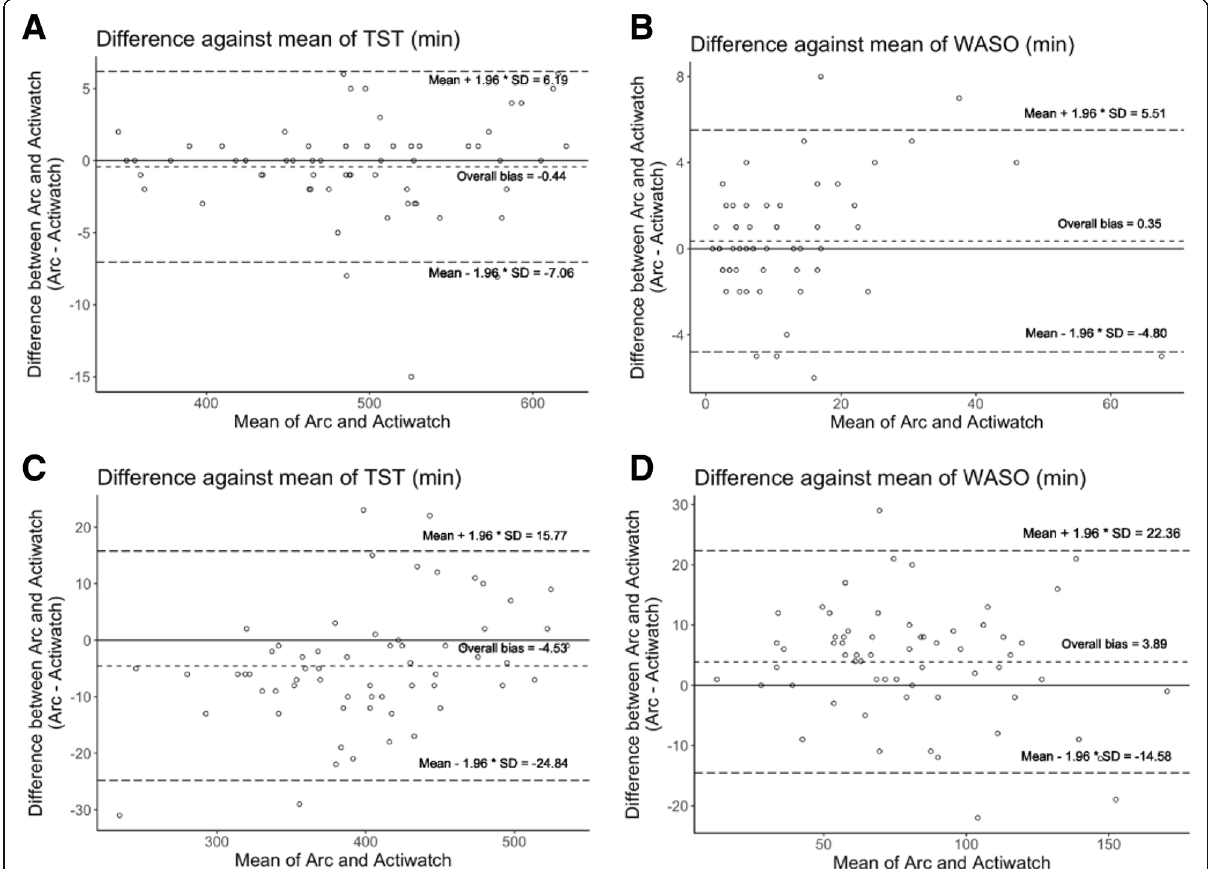
Fig. 4 a Bland-Altman plot of TST estimated by Arc as compared to Actiwatch. b Bland-Altman plot of WASO estimated by Arc as compared to Actiwatch. Data shown represent comparison of Arc using a constant factor of 1.1 in the wake threshold formula comparing to results generated by the auto algorithm from the Actiwatch. c Bland-Altman plot of TST estimated by Arc as compared to Actiwatch. d Bland-Altman plot of WASO estimated by Arc as compared to Actiwatch. Data shown represent comparison of Arc using a wake threshold of 5 comparing to results generated by the low algorithm from the